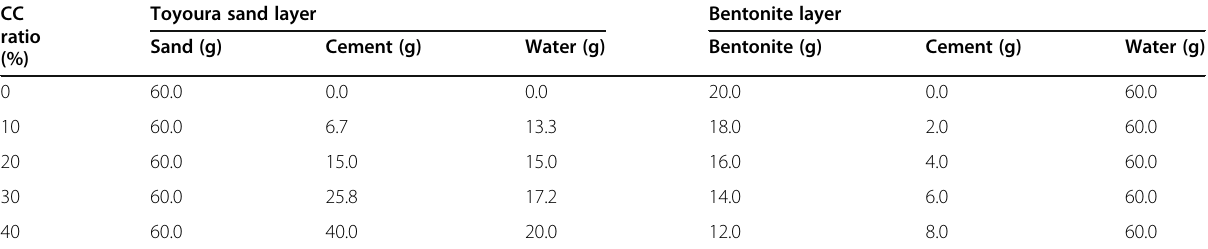
Table 1 Mixture proportions of Toyoura sand and bentonite layers CC Toyoura sand ratio (%)